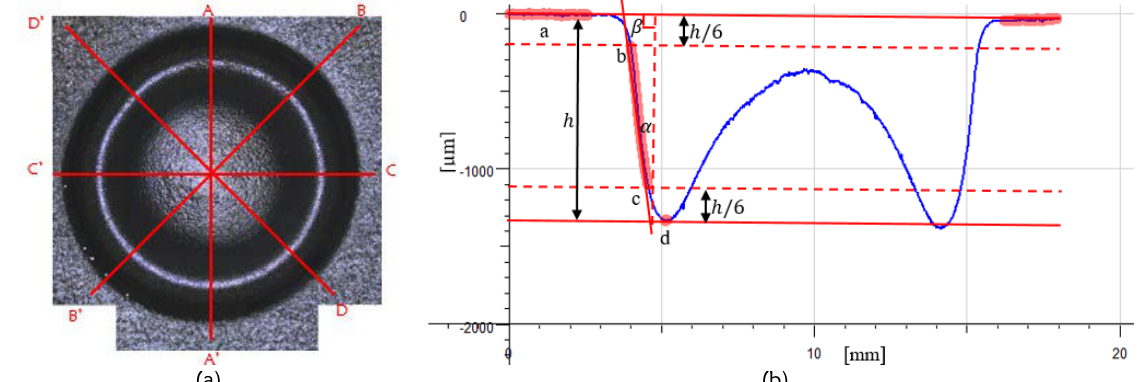
Figure 7: Typical 3D profile of an ECM’ed